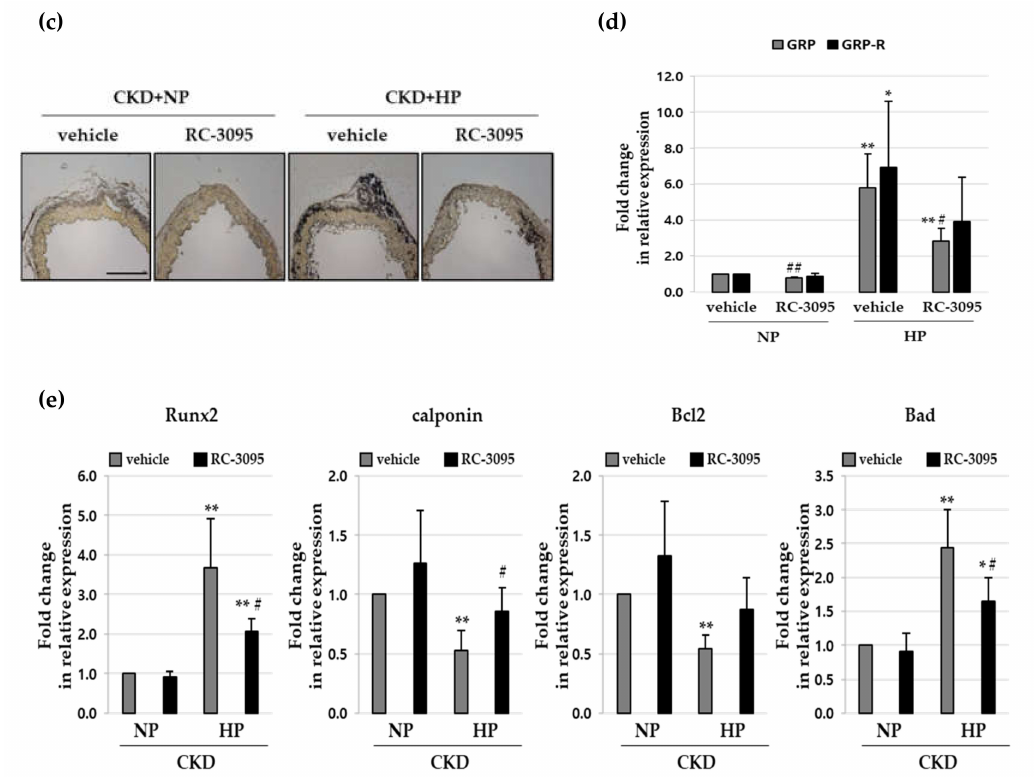
Figure 5. E ff ect of RC-3095 on vascular calcification in HP-fed CKD mouse. CKD mice were fed with a normal phosphate (0.5%, NP) or high phosphate (1.8%, HP) diet. For assessing the e ff ect of RC-3095 treatment, CKD mice were intraperitoneally injected with RC-3095 (1 mg / kg) or vehicle (0.9% saline) 3 times a week for a total 12 weeks. ( a and c ) Area of aortic calcification in CKD and sham mice was determined by von-Kossa staining. Scale bar: 50 µ m. ( b ) Total RNA was isolated and analyzed by real-time RT-PCR using the specific primers for mouse GRP and GRP-R . The expression level of these genes in the control (untreated) was set to 1 and the values were normalized to the β -actin mRNA levels. * p < 0.05; ** p < 0.01 vs. sham, # p < 0.05; ## p < 0.01vs. NP. ( d , e ) GRP, GRP-R, Runx2, calponin, Bcl2 and Bad mRNA levels were also examined by real-time RT-PCR. * p < 0.05; ** p < 0.01 vs. NP, # p < 0.05 vs. vehicle. Data shown are the mean ± SD, obtained from at least three independent